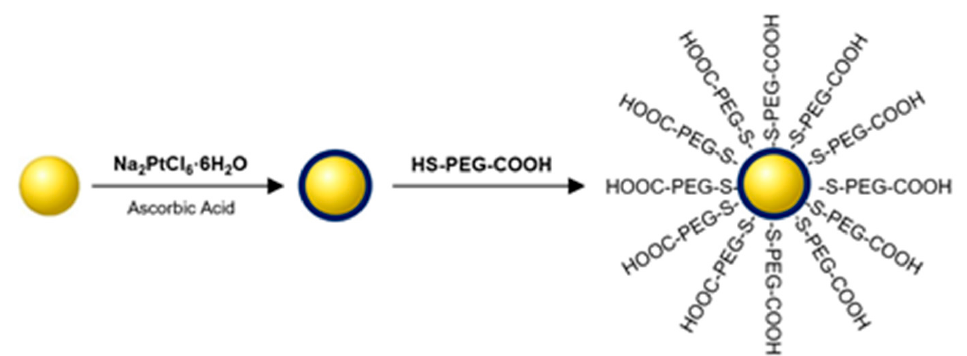
Figure 3. Graphical presentation of dependence the number of Pt layers formed ( A ) and yield of synthesis ( B ) in function of Pt 4+ nmoles used for the synthesis.